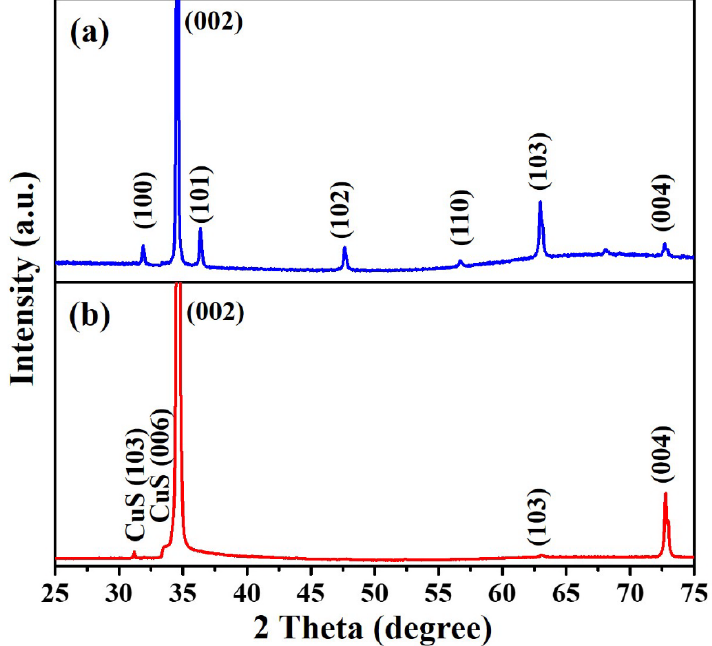
Figure 2. XRD patterns of ( a ) Er-doped ZnO nanowires and ( b ) Er-doped ZnO/CuS